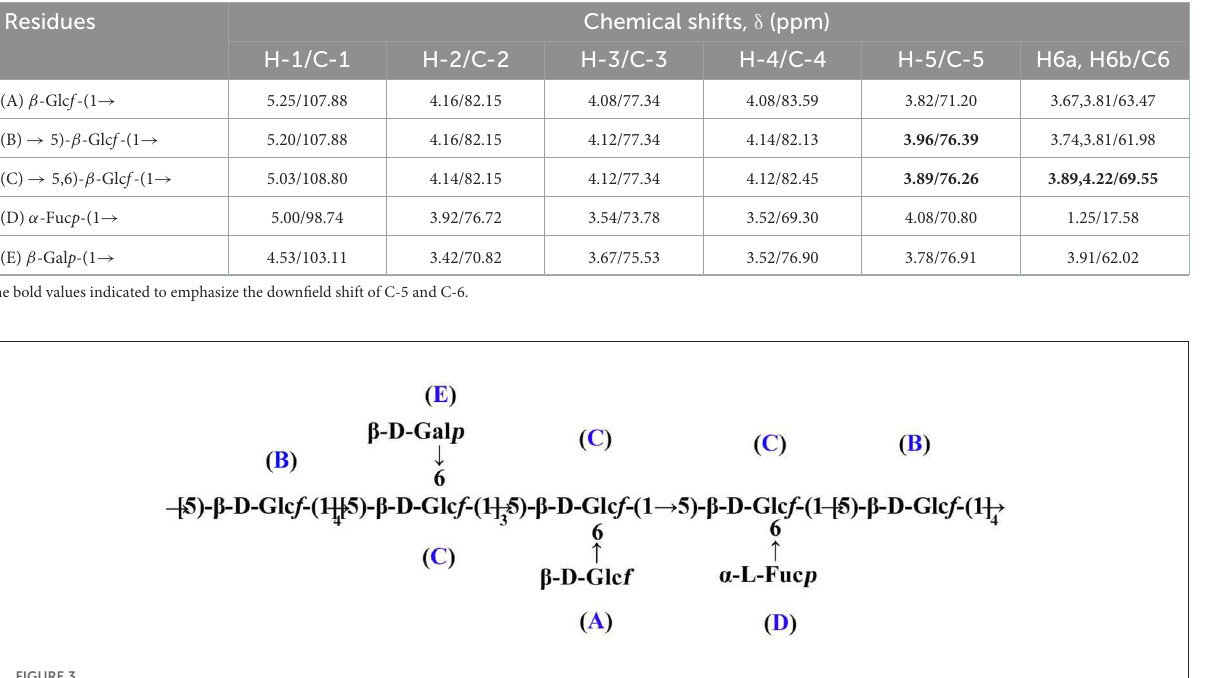
FIGURE3 Presumed main structure of